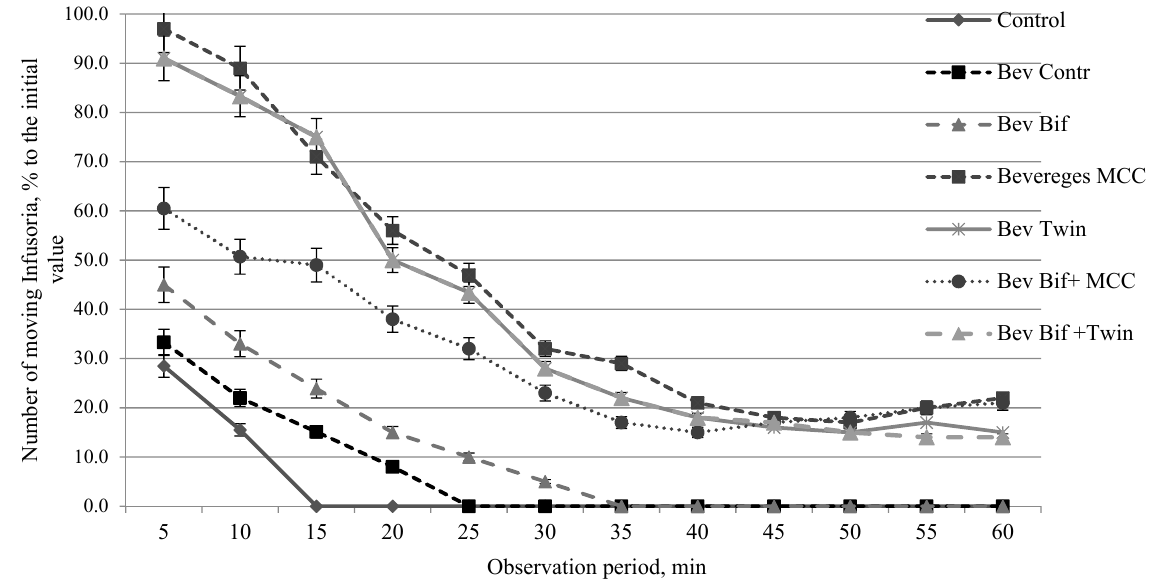
Figure 6. Membrane-stabilizing properties of plant beverages stabilized with ME in biotesting for Parametium caudatum . The error bars represent the standard deviation of measurements ( n = 5).